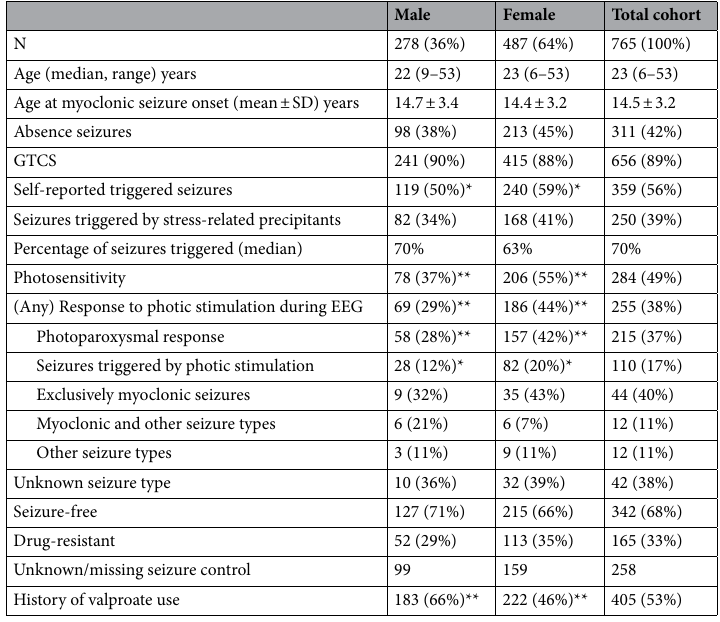
Table 1. Demographics and clinical characteristics of the JME cohort. For percentages, denominators are adjusted for missing data. *Sex difference, p < 0.05. **Sex difference, p < 0.001.